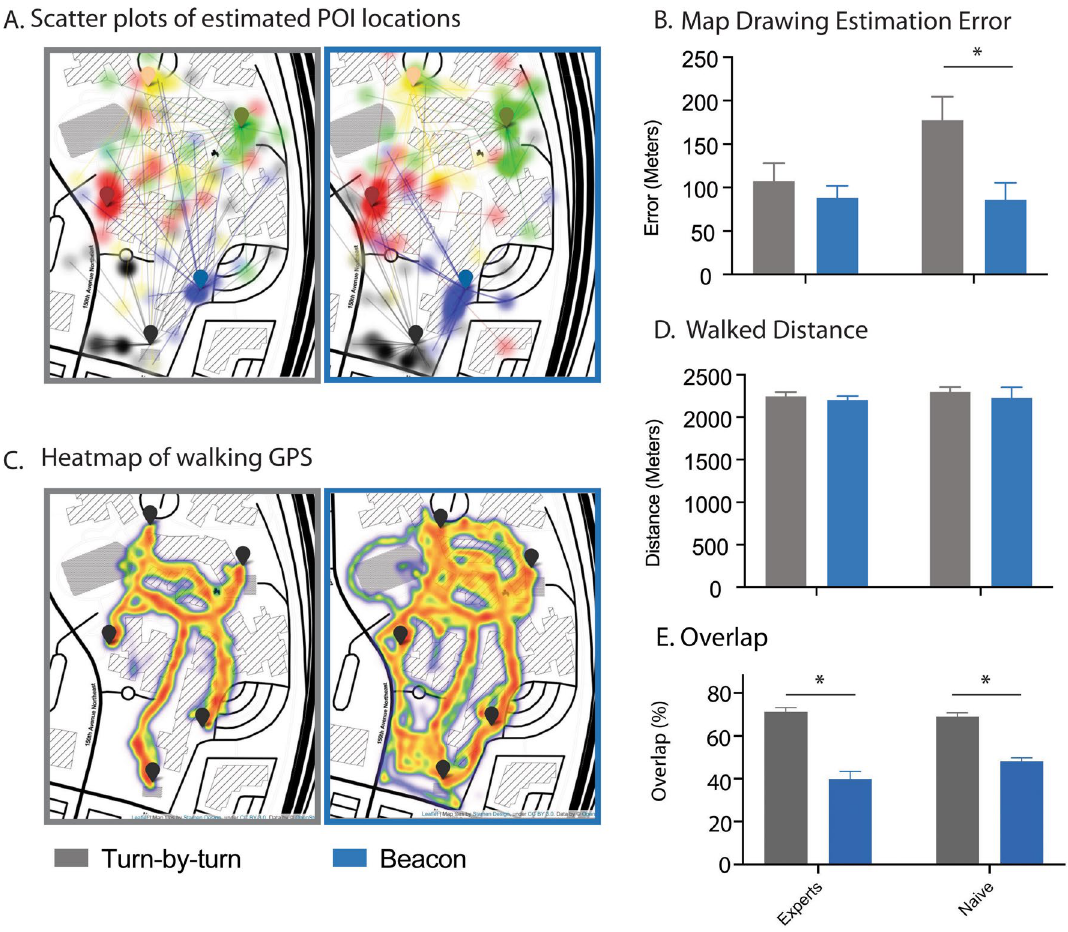
Figure 4. POI accuracy, path distance and routes taken during the scavenger hunt. ( A ) Estimated locations of all POIs of the Turn-by-turn (gray, left) and Beacon (blue, right) conditions. Each transparent colored circle represents one estimation by a participant and is linked to the corresponding POI flag by a transparent line, which represents the amount of error (Per POI and group views are available in the Supplementary material). ( B ) The amount of error between estimated and actual POI locations for all groups and conditions. ( C ) Heat map of the routes walked in the Turn-by-turn (gray, left) and Beacon (blue, right) conditions. The maps are created with the Folium package for Python on top of OpenStreetMap. ( D ) The distance (decimal°) walked during the scavenger hunt of all groups and conditions, and the overlay walked by the participants on the different conditions. All data are presented as ± SEM, * p < 0.05. ( E ) The overlap (percent %) of the paths taken during the scavenger hunt of all groups and